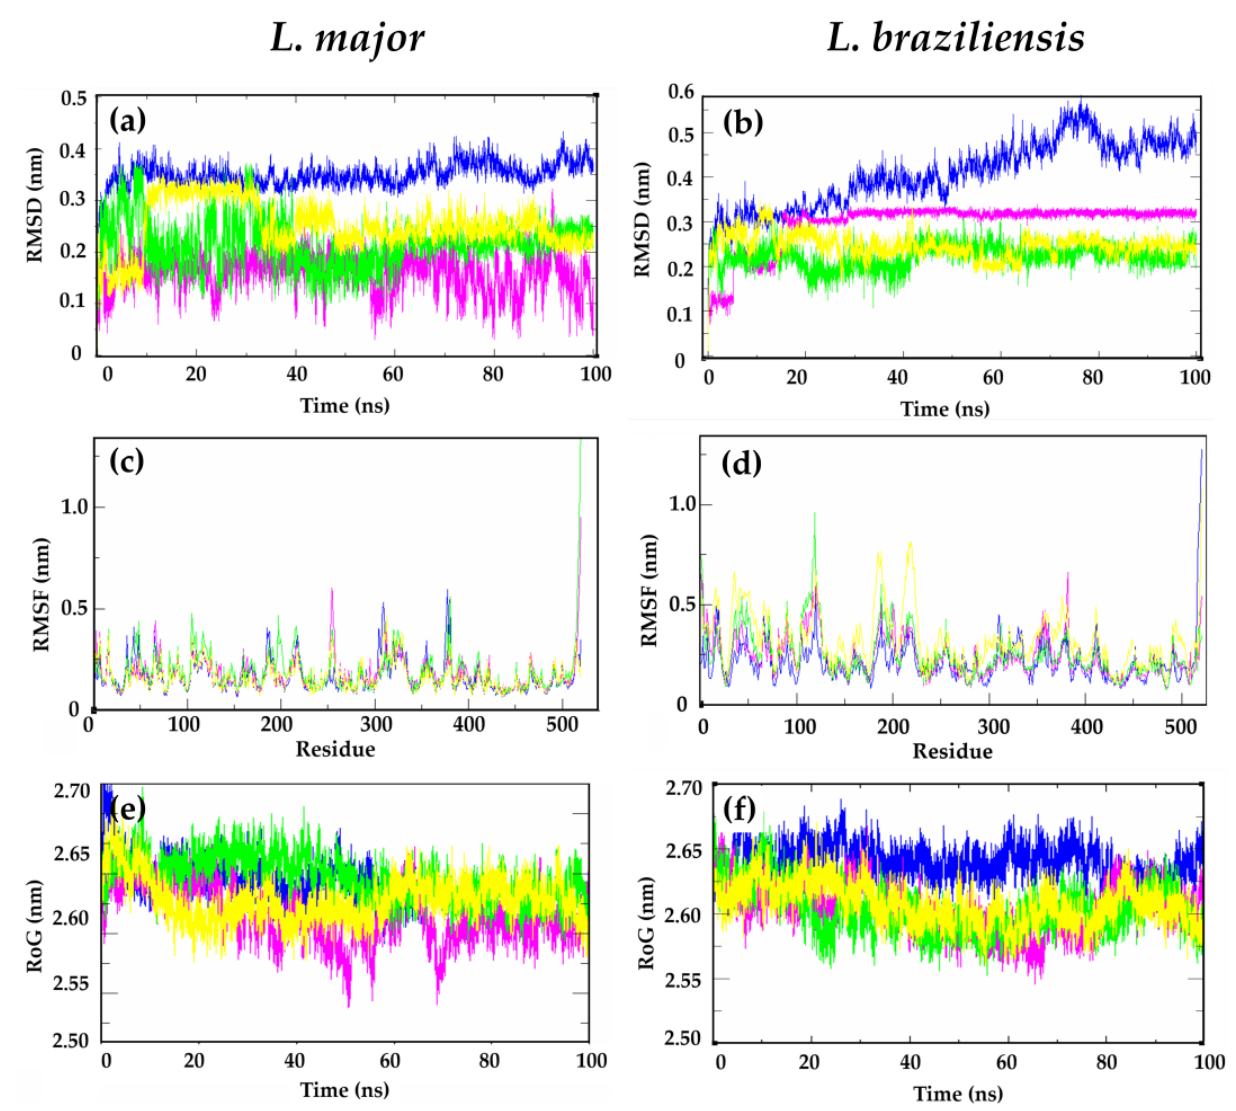
Figure 4. ( a , b ) Root-mean-square deviation (RMSD), ( c , d ) root-mean-square fluctuation (RMSF), and ( e , f ) radius of gyration (RoG) values within the L. major DHFR-TS and L. braziliensis DHFR-TS binding site, obtained after molecular dynamics simulations. Apoenzyme (blue); DHFR-TS:MTX complex (yellow); DHFR-TS: 302 complex (pink); DHFR-TS: 302a complex (light green). Afterward, we analyzed the flexibility of residues with different ligands using root-mean-square fluctuation (RMSF) values. Similar patterns were found in both L. major and L. braziliensis during the entire dynamic simulations (Figure 4c,d). Regions with defined tertiary structures ( α -helices or β -sheets) showed similar RMSF values (0.1 to 0.3 nm) for structure 302 and its derivative 302a in complex with L. major DHFR-TS, as well as for the apoenzyme. However, the control compound MTX presented higher RMSF values, particularly in loop regions of the protein. On analyzing the RMSF values in L. braziliensis DHFR-TS, the Lb DHFR-TS: 302 and the apoenzyme showed similar behaviors over the simulation time, while structure 302 had higher fluctuations in loop regions than MTX and the uncomplexed protein, especially in the region from A113 to T121, where values ranging from 0.30 nm to 0.63 nm were observed. Despite this, in regions with defined tertiary structure, both MTX and the kaurane 302a showed RMSF values lower than 0.30 nm, which indicates low flexibility in L. major DHFR-TS when complexed (Figure